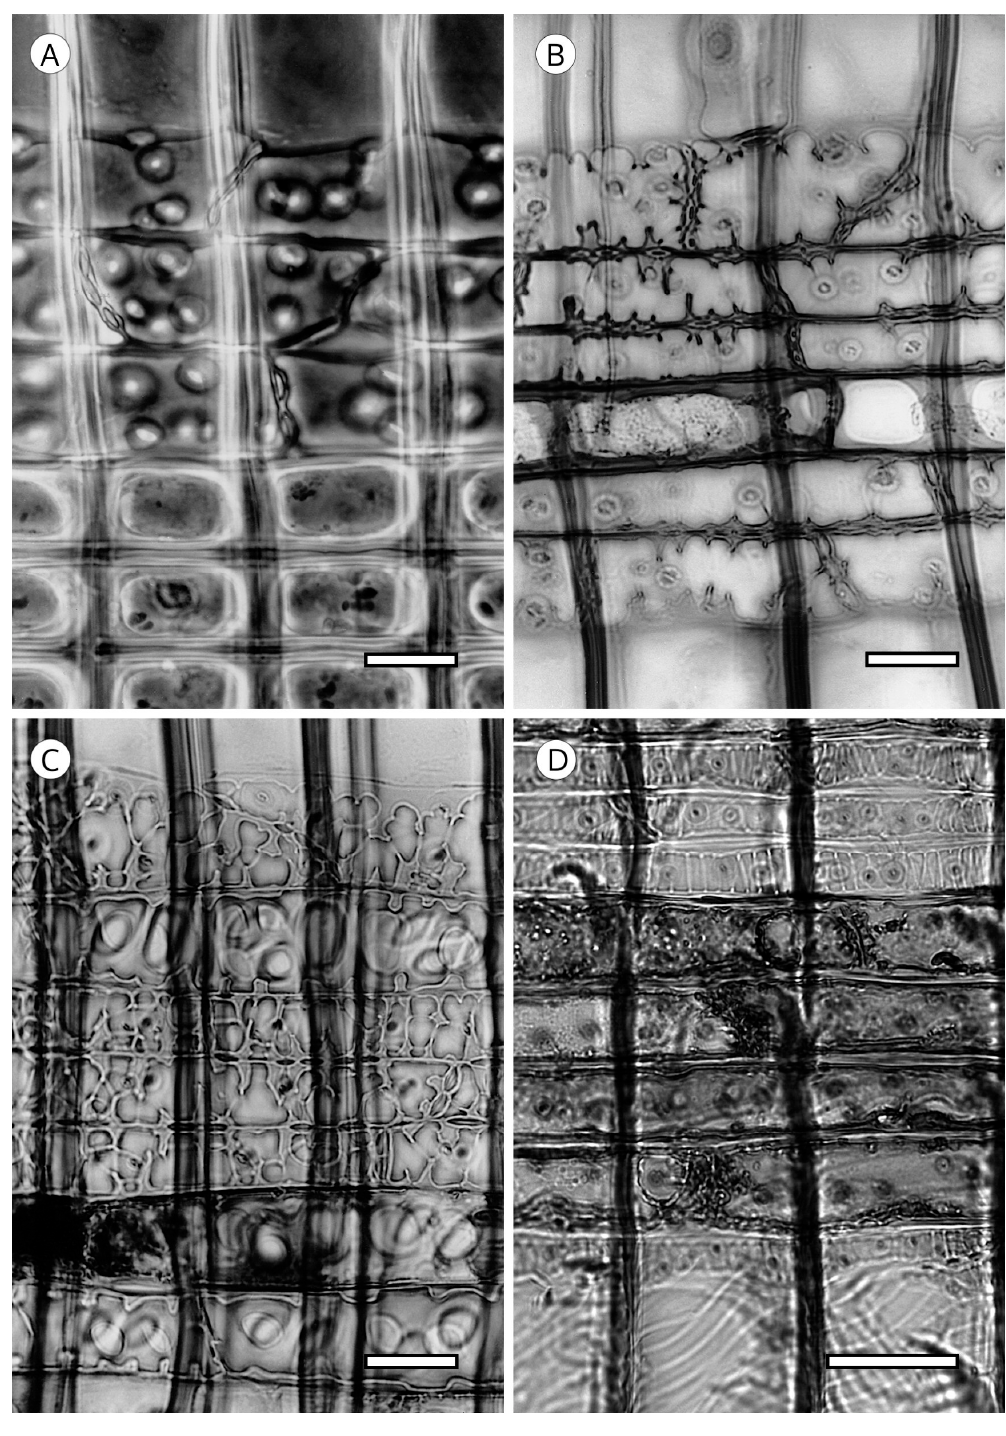
Figure 30. Ray tracheid walls. ( A ) Smooth in Pinus strobus L.; ( B ) Dentate in Pinus sylvestris L.; ( C ) Reticulate in Pinus pungens Lamb; ( D ) With helical thickenings in Pseudotsuga sinensis Dode. Scale bars. ( A – D ) = 25 μ m.